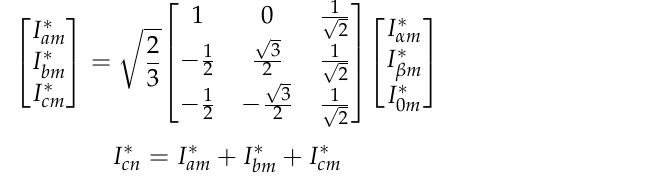
Figure 5. Bode diagram of ( a ) G V K i